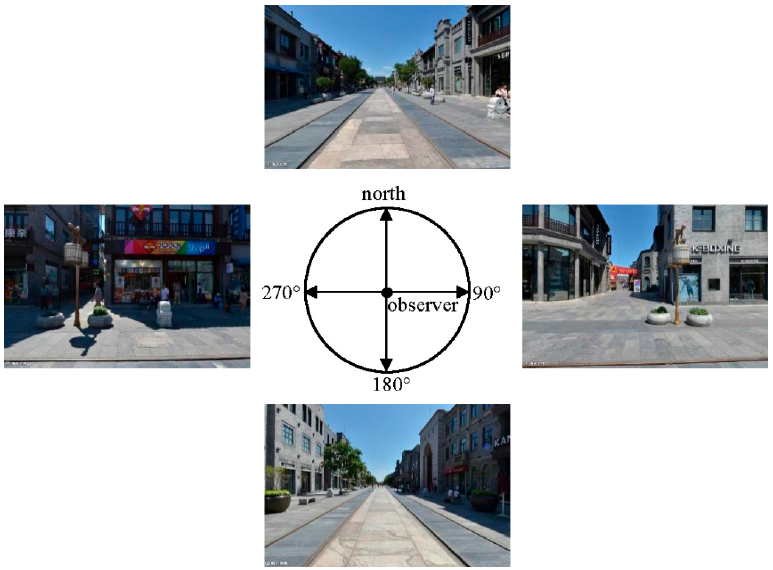
Figure 3. Tencent Street View image download parameter configuration.